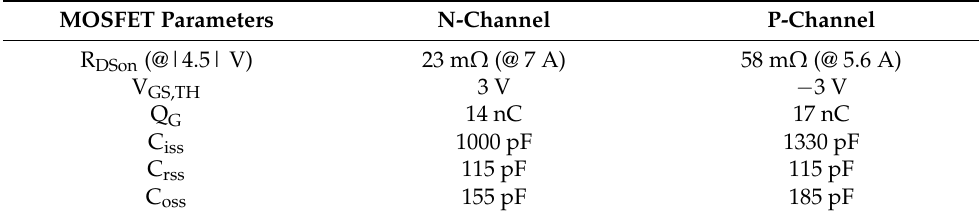
Figure 17. ( a ) Block schematic of DC ‐ DC power converter and auxiliary power supply’s arrange ‐ ment. ( b ) Picture of experimental converter DC ‐ DC power converter and auxiliary power supplies arrangement. Table 1. Main power MOSFETs parameters.